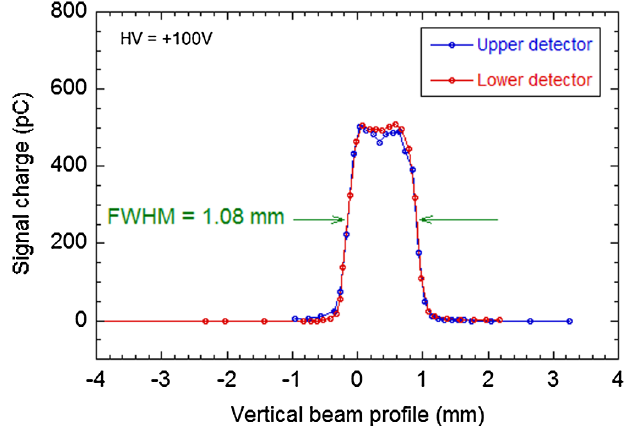
FIG. 9. Profiles of a weak beam (blue line: upper detector; red line: lower detector).